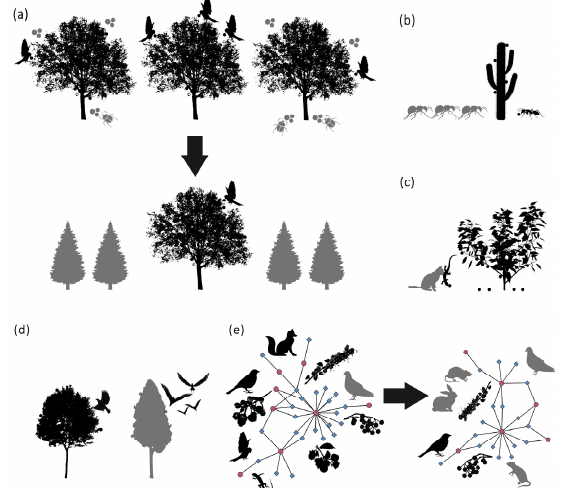
Figure 2. Mechanisms explaining the disruption of plant–disperser mutualism, based on reviewed studies: ( a ) forest pathogens transmitted by exotic species cause a decrease in the population of native trees, with the consequent loss of plant–frugivore interaction and facilitating the invasion of exotic plants; ( b ) exotic species affect dispersal behaviors and visitation rates of native dispersers; ( c ) feral cats predate native frugivorous lizards, disrupting seed dispersal services; ( d ) exotic plants compete with natives for frugivore species; and ( e ) exotic plants negatively influence disperser di ‐ versity and alter dispersal networks. Exotic species are represented in gray, and natives in black. Seed dispersal disruption caused by exotic species in the case studies examined de ‐ pended on different mechanisms that affect mutualistic interaction between native plants and their dispersers. Sometimes, the disruption of plant–disperser mutualisms relies on more than one species, as in the case of the exotic forest pathogens causing laurel wilt disease in many native Lauraceae species from the USA. These species are responsible for the decline in native plant populations and the consequent disruption of the frugivorous interaction between birds and plants, facilitating the invasion of other exotic plants [48]. Other mechanisms include displacing or affecting dispersal behaviors and visitation rates of native dispersers [4,12,13,18,49–56], modifying patterns of habitat selection by seed dis ‐ persers [19,57], predation of native dispersers [58], competition for dispersal services by exotic plants [59,60], and reduction in seed dispersal network complexity [61].